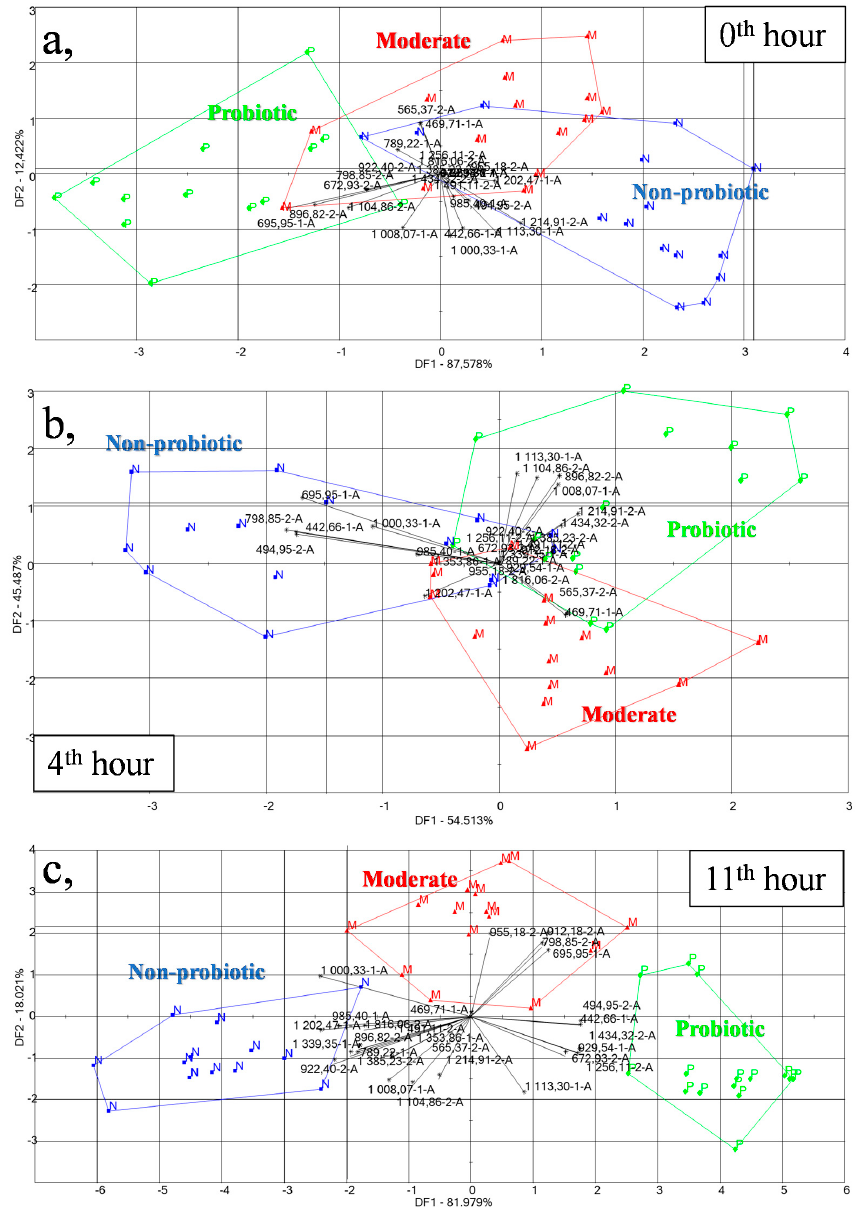
Figure 5. Discrimination of the milk samples inoculated with the 15 bacteria strains based on the probiotic, moderately probiotic, and non-probiotic groups using their aroma composition measured by the e-nose ( a ), at the beginning (0th hour, n = 45), ( b ), after four hours (4th hour, n = 45), and ( c ), after 11 h (11th hour, n = 45) of fermentation.